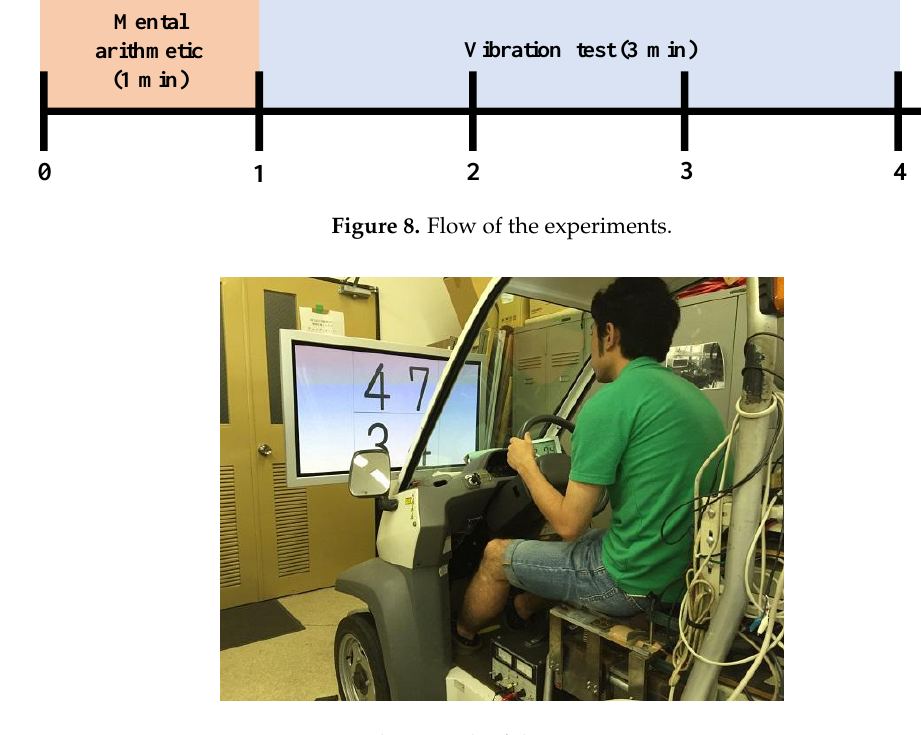
Figure 9. Photograph of the experiment set up.